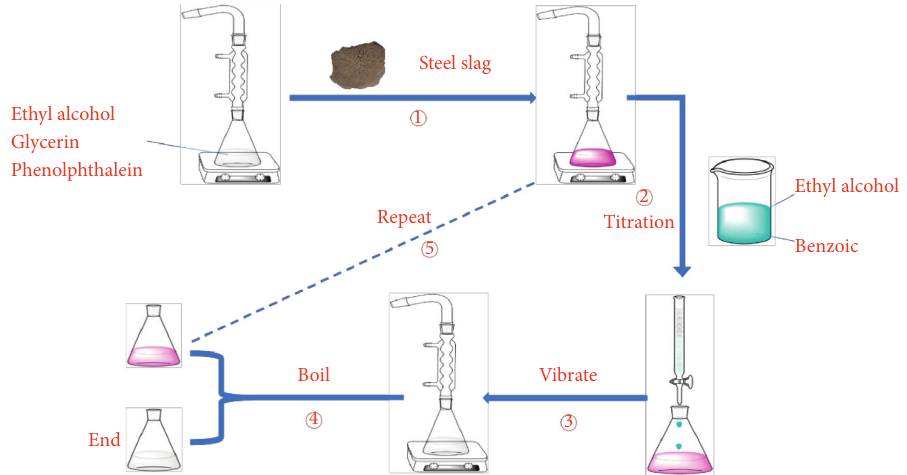
Figure 1: Schematic of the determination process of free calcium oxide in steel